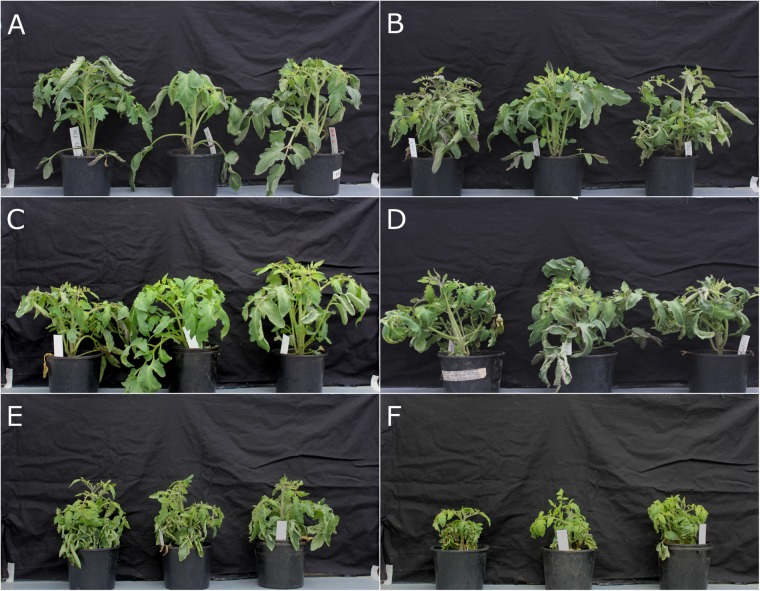
Fusarium wilt disease assay on rmc and 76R tomatoes confirming rmc as more susceptible to Fusarium oxysporum f. sp. lycopersici (Fol) race 3 than 76R. (A) Tomato 76R and (B)
rmc were inoculated with Fol race 1; (C,D) 76R and rmc were inoculated with Fol race 2; (E,F) 76R and rmc were inoculated with Fol race 3. Plants were inoculated using a root dip method and photographed 3 weeks after inoculation.